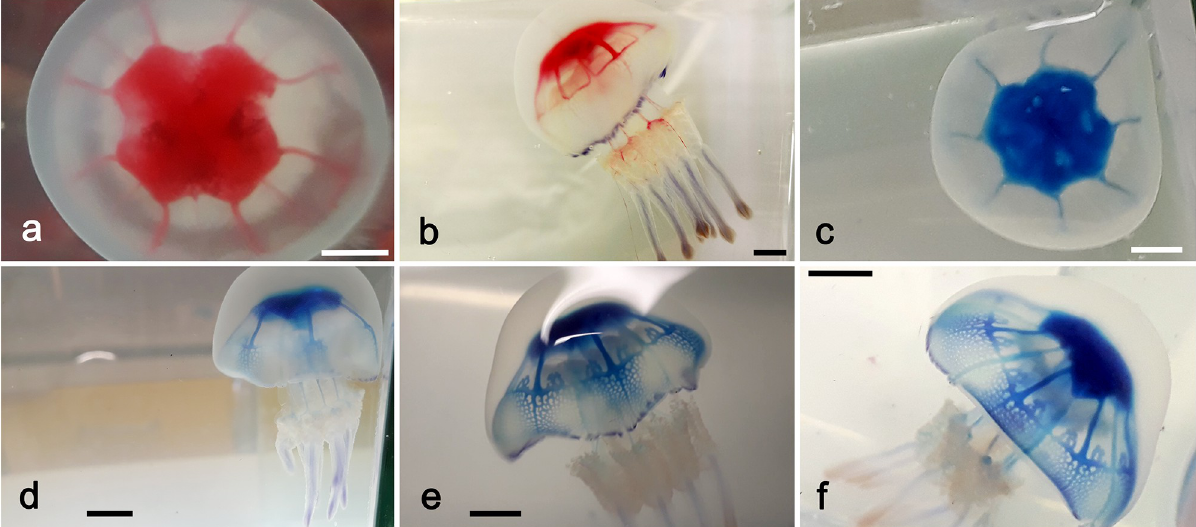
Fig 9. Functional anatomy of the gastrovascular system. (a) Living specimen with stained stomach, with stain diffusion into the adradial canals after 1 min from the injection (scale bar = 1 cm). (b) Same specimen, lateral view, after 1 min from (a). Staining of the internal ring canal. Manubrium: the stain transits into the external hemi-canals, and the upper openings of the external oral arm wings (scale bar = 1 cm). (c) Similar to (a), but specimen injected with methylene blue stain (scale bar = 1 cm). Adradial canals stained. (d) Initial coloration of the inner ring canal and the outwards adjacent anastomosed canals mesh (scale bar = 1 cm). (e) Beginning of coloration of the per- and interradial canals inside the inner ring canal. Beginning of coloration of the distal ring canal (scale bar = 1 cm). (f) Umbrellar canal system now completely stained (scale bar = 1